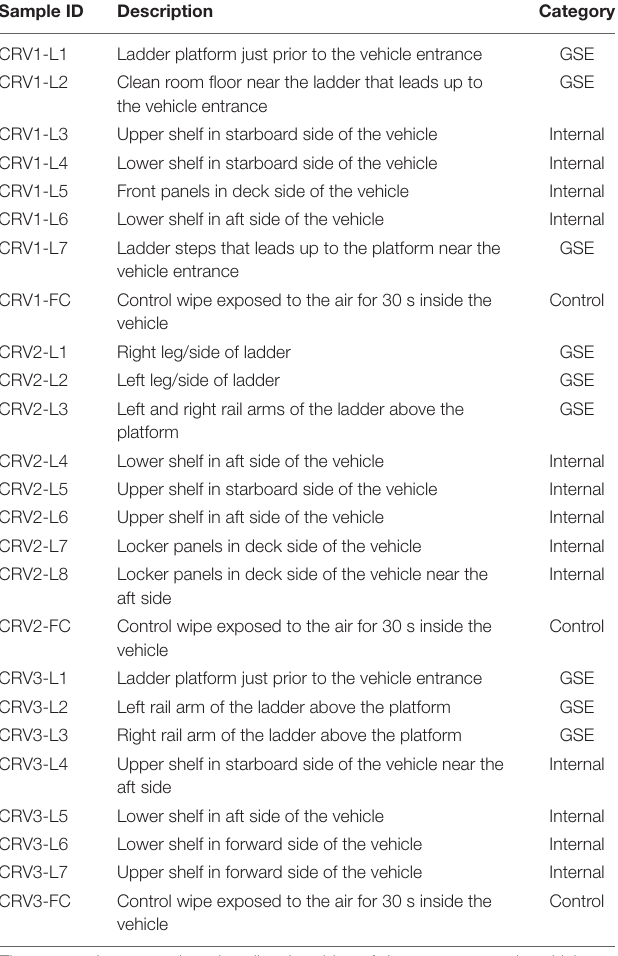
TABLE 1 | Descriptions of sampling locations on commercial resupply